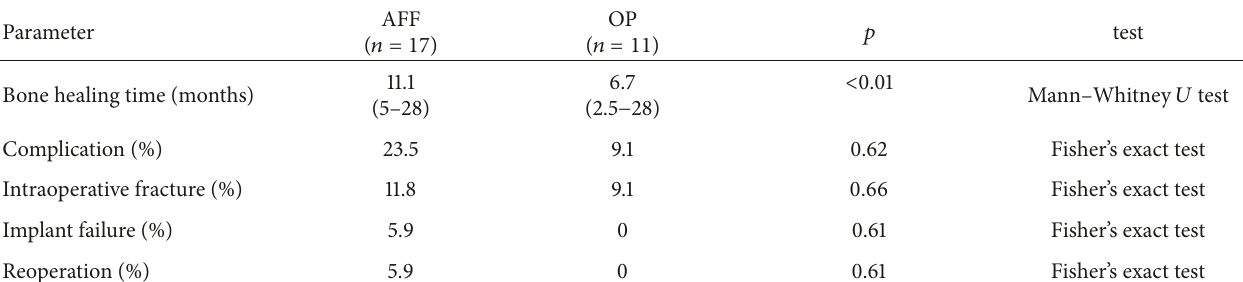
Table 2: Comparison of bone healing time and complication rates.